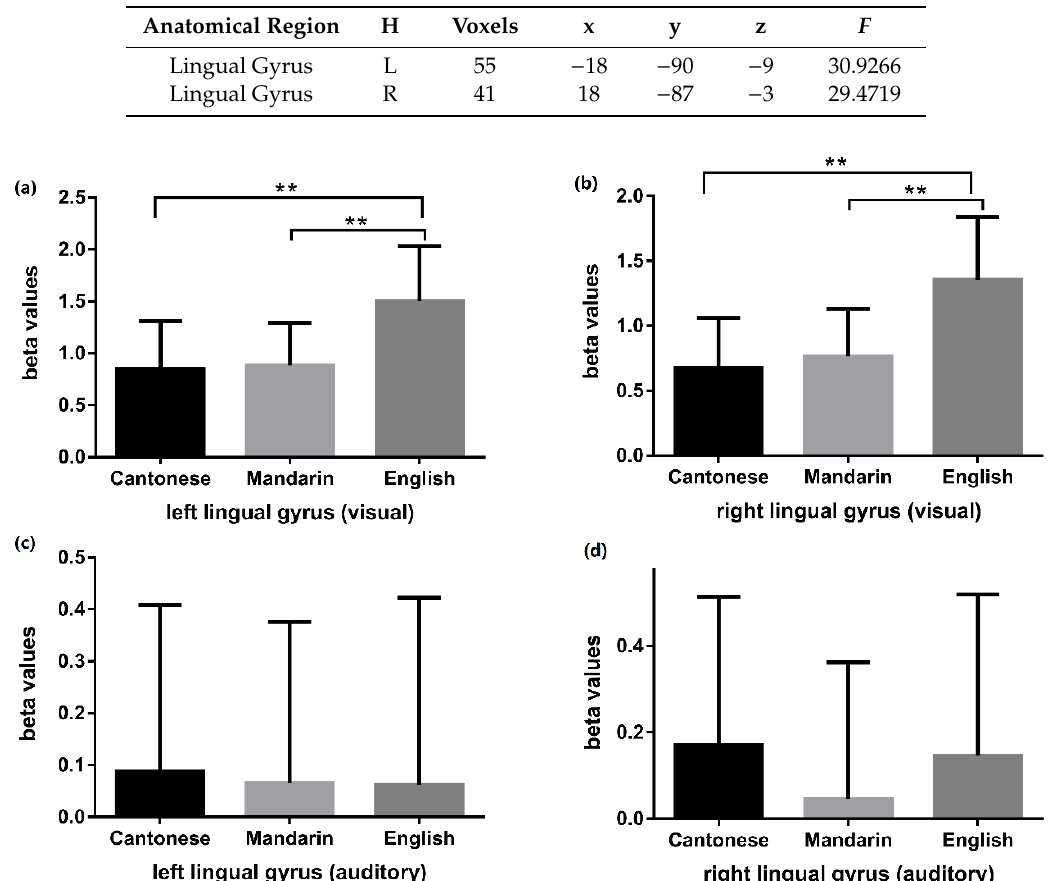
Figure 7. Language comparisons (Cantonese vs. Mandarin, Cantonese vs. English, Mandarin vs. English) of beta values in bilateral lingual gyri during visual and auditory tasks. Panel ( a ) and panel ( b ) respectively displayed the language comparison results of beta values in the left and right lingual gyrus during visual tasks. The visual phonological processing of English induced greater activity than that of Cantonese and Mandarin in bilateral lingual gyri. Panel ( c ) and panel ( d ) respectively displayed the language comparison results of beta values in the left and right lingual gyrus during auditory tasks. No significant differences were detected between the auditory phonological processing of the three languages. ** indicates p < 0.01.